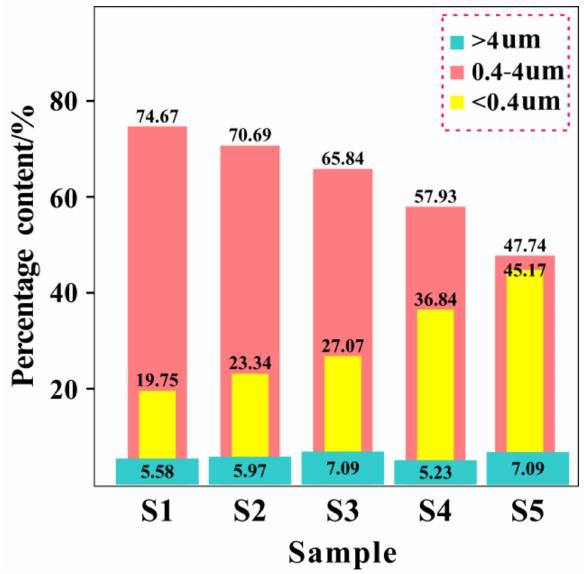
Figure 9. Variation of pore content at all levels of soil samples in different reclamation areas.